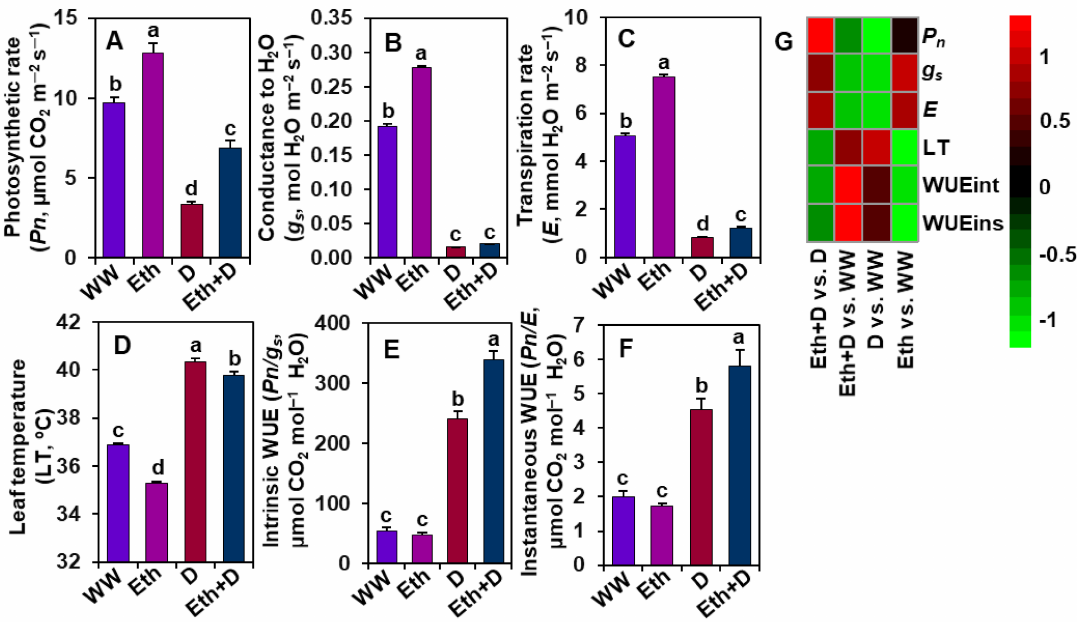
Figure 2. Effect of exogenously supplied 20-mM ethanol on ( A ) photosynthetic rate ( Pn ), ( B ) stomatal conductance to H 2 O ( g s ), ( C ) transpiration rate ( E ), ( D ) leaf temperature (LT), ( E ) intrinsic WUE (WUEint), and ( F ) instantaneous WUE (WUEins) of soybean leaves subjected to drought stress for a period of 8 days. ( G ) Heatmap of the fold-change values of the aforementioned parameters in soybean plants under different treatments. Bars represent means with standard errors ( n = 4). Different letters shown above the bars are used to indicate significant differences among the treatments ( p < 0.05). WW, Eth, D, and Eth + D indicate water-sprayed well-watered plants, ethanol-sprayed well-watered plants, water-sprayed drought-exposed plants, and ethanol-sprayed drought-exposed plants,